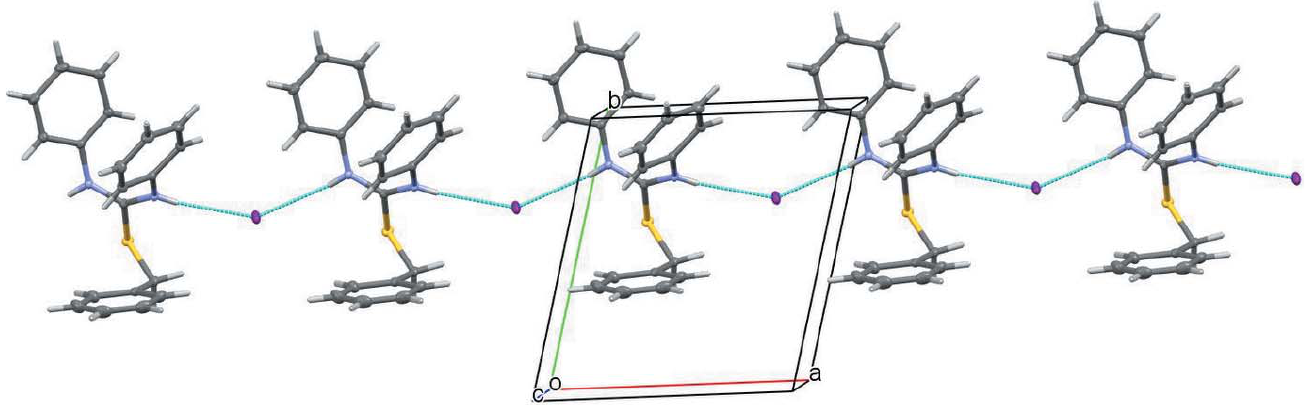
Figure 2 A view of a fragment of the [100] chain arising from N—H (cid:2)(cid:2)(cid:2) I hydrogen bonds.